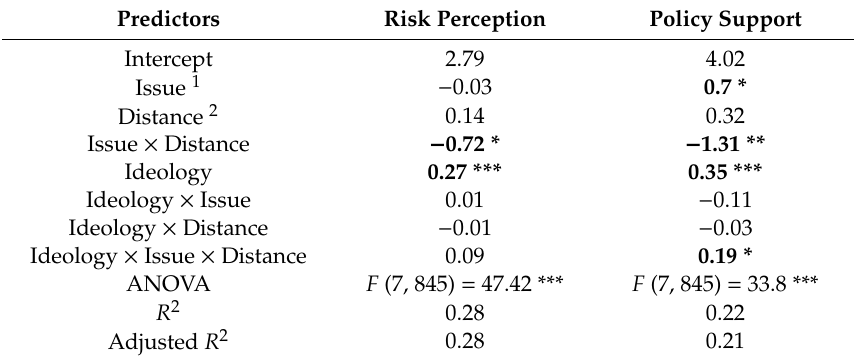
Table 1. Regression models predicting risk perception and policy support with message frames, ideology, and their interaction (unstandardized regression coe ffi cients). Predictors Risk Perception Policy Support Intercept